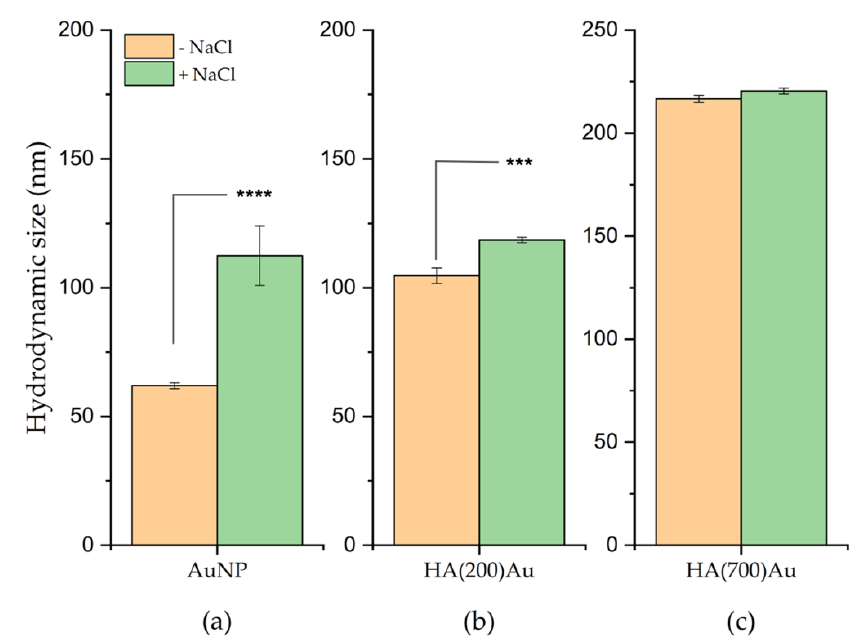
Figure 5. UV-visible spectra of bare AuNP ( a ) before (solid line) and after (dashed lines) the gradual addition of NaCl aqueous solution at increasing concentrations from 0.05 M to 0.5 M. The UV-visible spectra before (solid line) and after (dashed lines) the direct addition of 0.5 M NaCl are shown in ( b ) for HA(200)Au (0.11 nM = 4 × 10 3 AuNP/mL) and in ( c ) for HA(700)Au (0.06 nM = 6 × 10 2 AuNP/mL).